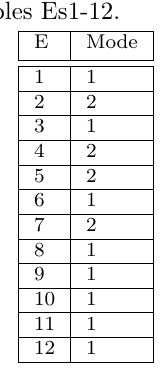
Table 4: Es7-12. The table shows the main perfor- mance objective V M (Eq. (8)) measures for the δ -PRC and Opt-PRC tuned PID con- trollers, i.e. corresponding to the trade-off curves in Figure 5. E \ V M δ -PRC Opt-PRC